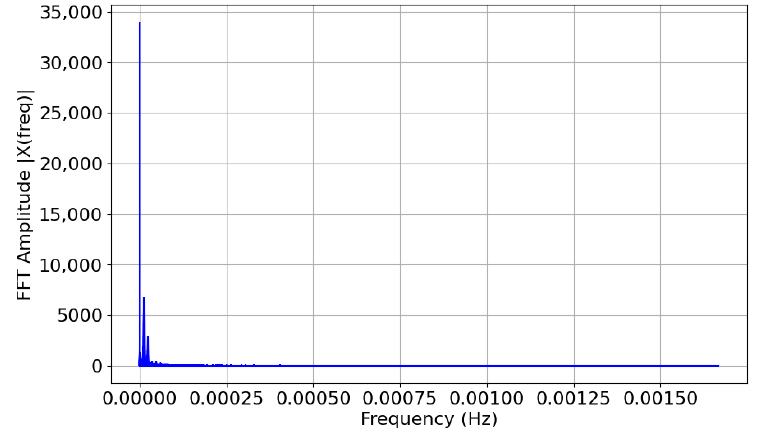
Figure 2. Fourier Transform plot of an input feature, denoting the frequency distribution present in the input signal. The plot is obtained by using Fast Fourier Transform